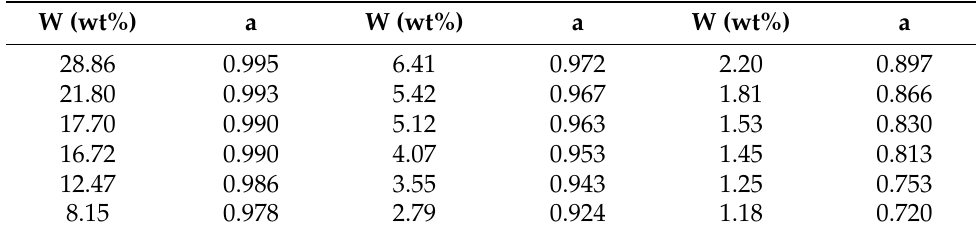
Table 4. Experimental data on the water activity a of kaolinite clay via different water content (W) levels at 298.15 K and atmospheric